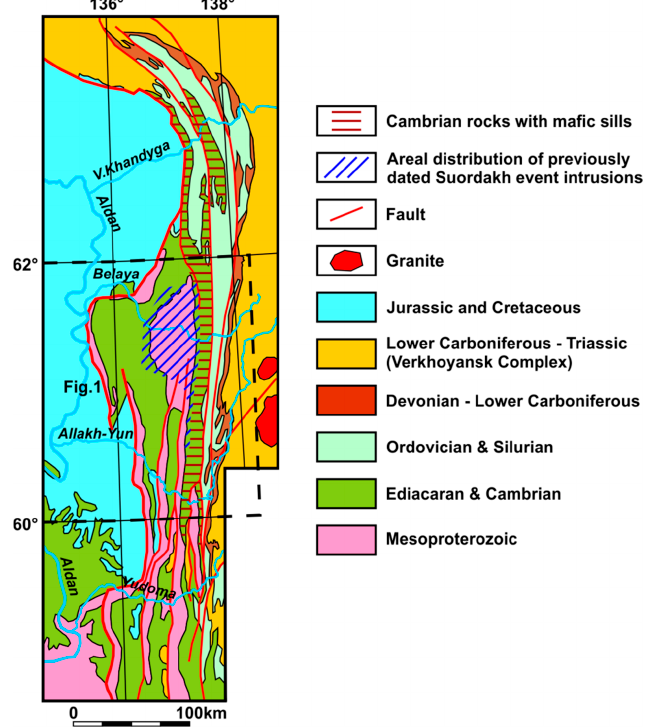
Figure 13. Areal distribution of the previously dated Suordakh event mafic intrusions [10], and their possible extent within Cambrian rocks with reference to the new U-Pb dating of the X04-14-1 mafic sill. Geology from [22,26,54]; simplified and modified.